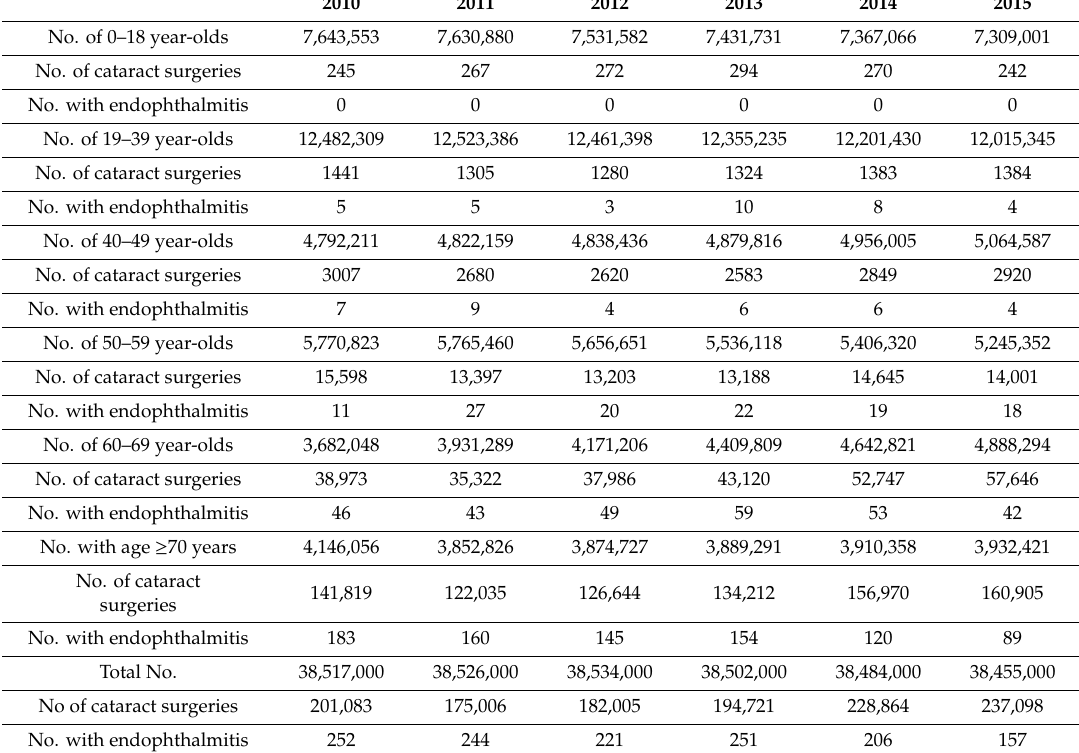
Table 1. The total number of postoperative endophthalmitis (POE) cases and the total number of cataract surgeries performed in Poland from 2010–2015 matched with population data by age